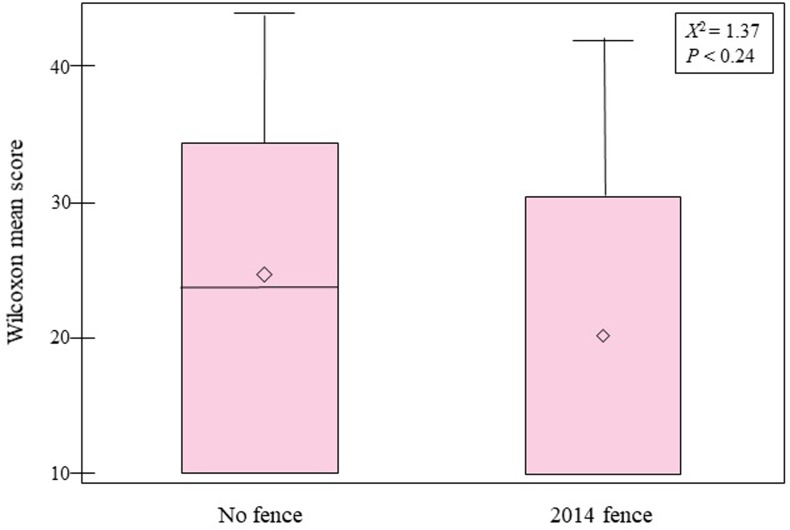
Wilcoxon–Mann–Whitney U test results displayed in box plots showing no significant difference (χ2 = 1.37, p < 0.24) in regeneration ha-1 between No Fence and 2014 Fence treatment groups.Output from the test is shown in Wilcoxon mean scores on the y-axis (SAS®). Whiskers show minimum and maximum values (no line indicates Wilcoxon score of zero), boxes represent 25–75% data ranges, horizontal lines within boxes are medians, and diamond symbols are means.